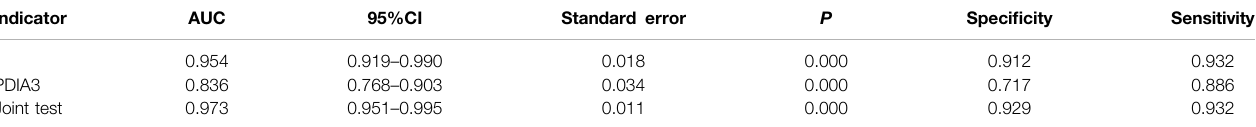
TABLE 7 | Value of HP and PDIA3 levels to assessment of colorectal cancer patients at progressive stage.